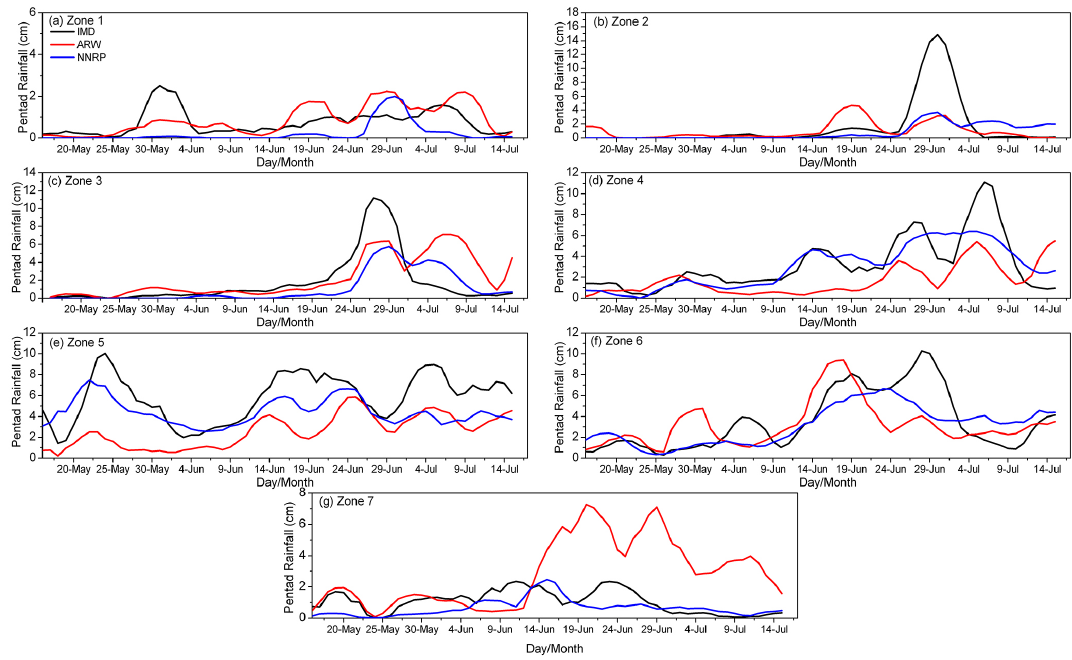
Figure 3. Time series of running pentad rainfall (cm) averaged over different rainfall zones in the period 12 May–30 June 2002 along with corresponding pentad rainfall derived from NNRP reanalysis and IMD 50km gridded rainfall data. The first pentad is 12–16 May, the second pentad is 13–17 May...and the last pentad is 26 June–30 June. Panels (a) to (g) correspond to zone 1 to zone 7.